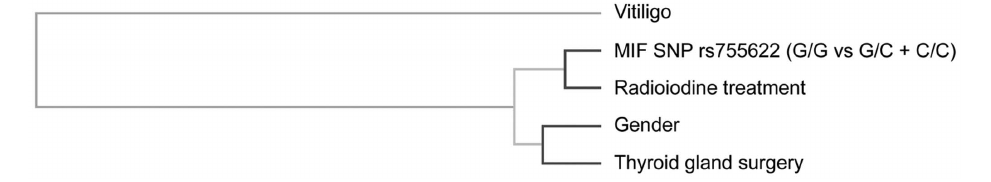
Figure 1. Interaction dedrogram. The location of the longitudinal connecting bars indicates the strength of the dependence: left is weaker and right is stronger. The hierarchical cluster analysis placed MIF SNP rs755622 genotype (GG vs GC + CC) and radioiodine treatment on the same branch, demonstrating the most strong interaction between these two factors. Gender, thyroid gland surgery and vitiligo are also included in the dendrogram as shown. MIF , macrophage migration inhibitory factor; SNP, single nucleotide